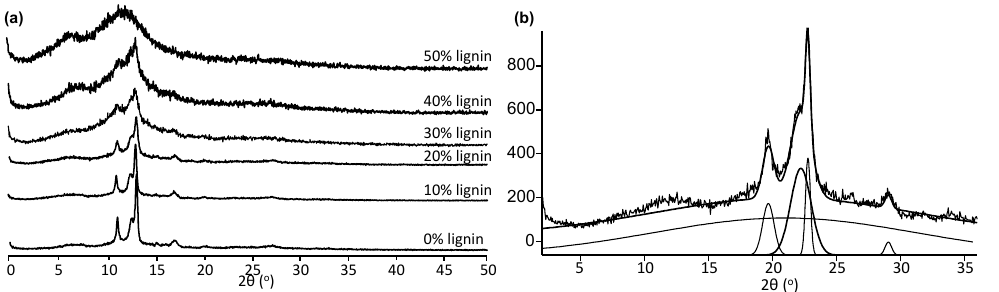
Figure 8. X-ray diffractograms of ( a ) BS0.8T-0 − 50%lignin copolymers and ( b ) BA1-20%lignin copolymer showing peak fitting.